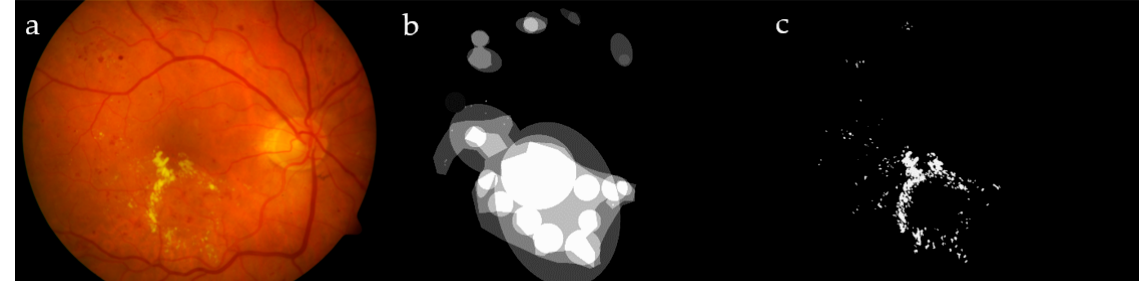
Figure 1. Image #19 from DIARETDB1 ( a ); ground truths from the dataset ( b ) and by our ophthalmologist ( c ), for a visual comparison.